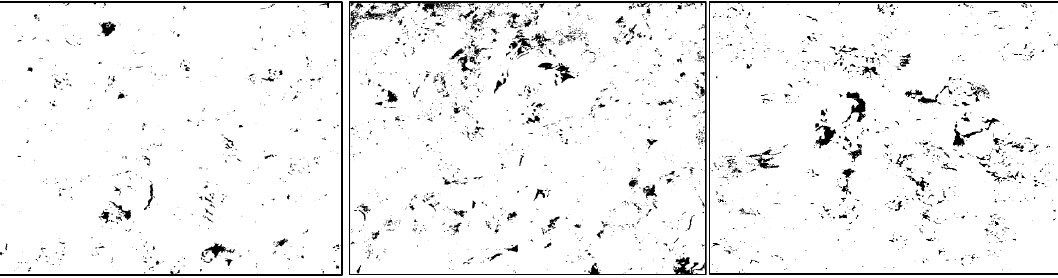
Figure 6. Matrix surface porosity measured in different directions of CZ-Y47-1. ( a ) Parallel bedding direction: 1.8%, ( b ) #1 perpendicular bedding direction: 3.6%, ( c ) #2 perpendicular bedding direction: 3.4%.